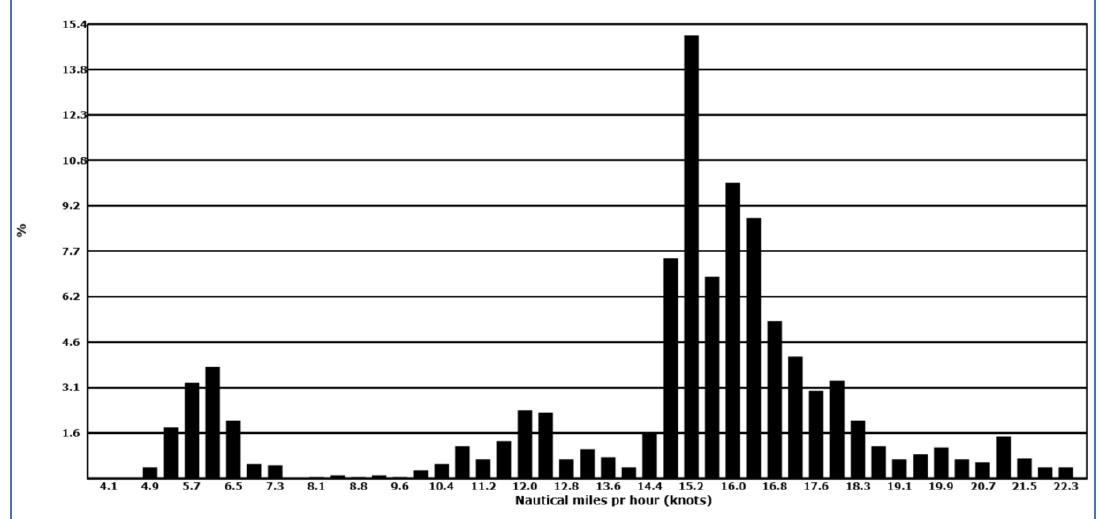
Figure 6. Speed profile for Norwegian Star (May 2016).